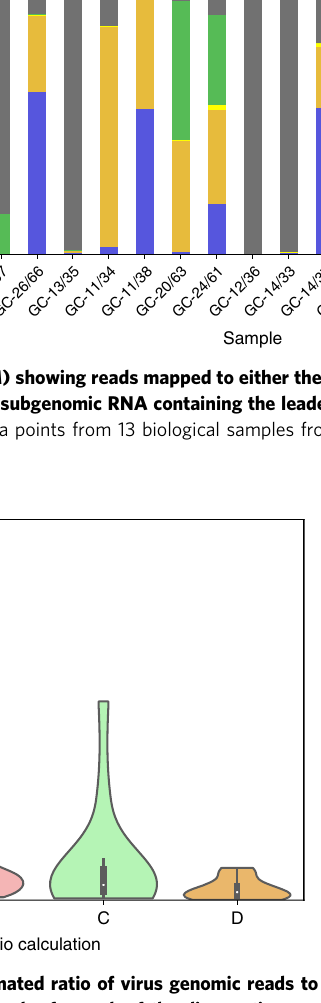
our study. It should be mentioned, that we had to dilute the cDNA used for these PCRs as we had limited amounts available. The differences in Ct values between the 7a subgenomic and the genomic targets for the samples with a positive PCR is shown in Table 5 and Supplementary Fig. 4. With the ampli fi cation ef fi ciency of these assays the difference corresponds to around 4-fold to 20-fold more of the genomic target than of the 7a subgenomic RNA-speci fi c PCR target.